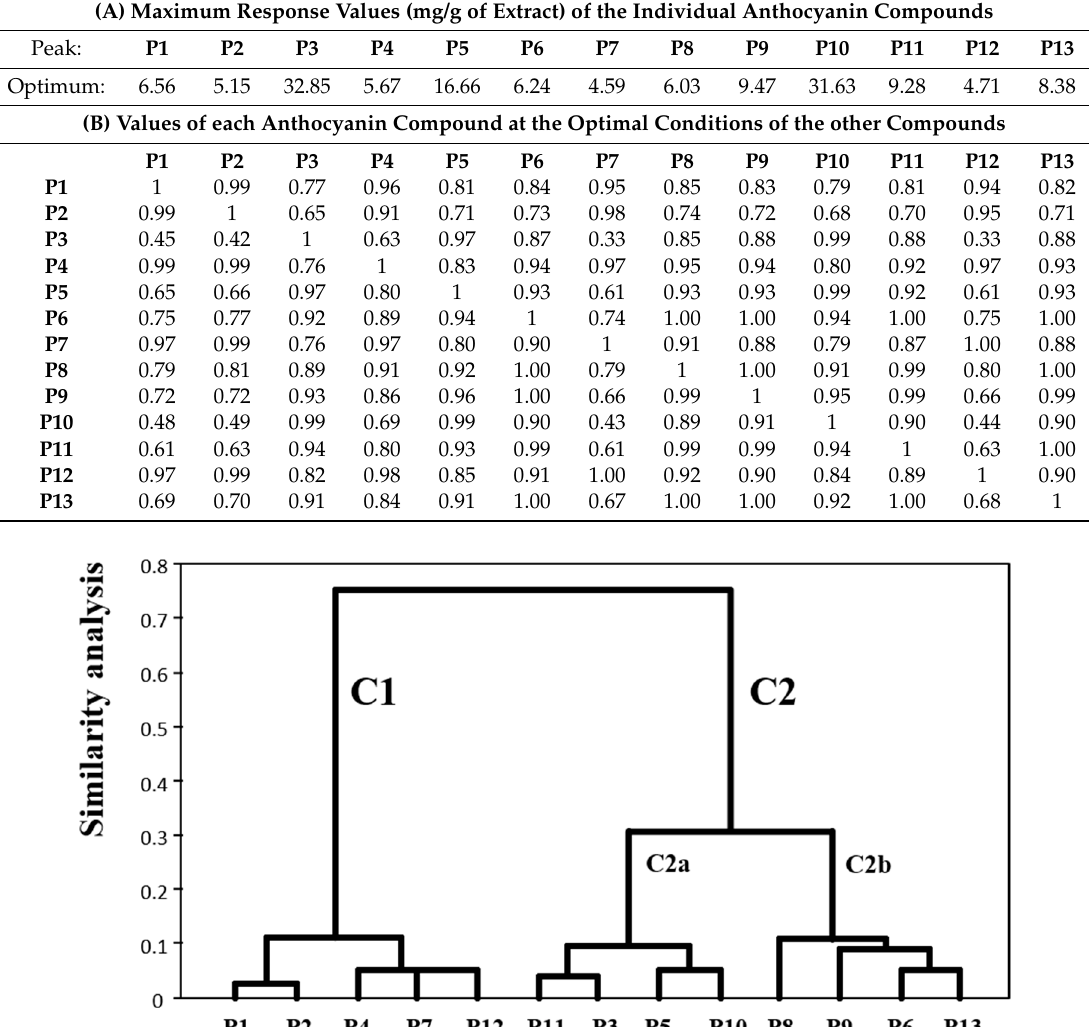
Figure 5. HCA dendrogram of anthocyanin compounds according to the HAE conditions that maximize their extraction from red rubin basil leaves.